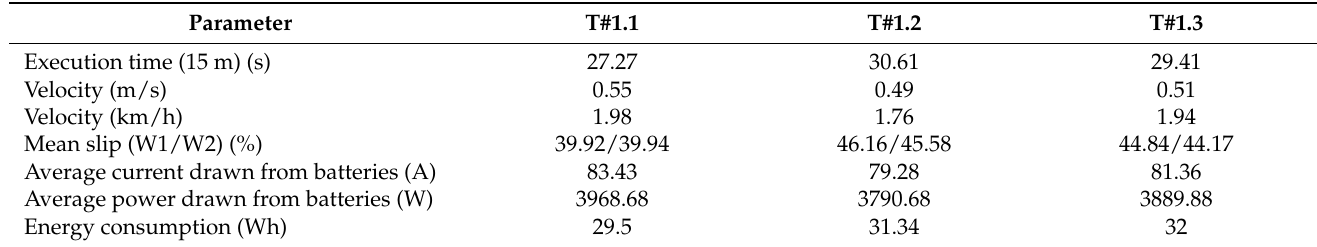
Figure 19. Energy consumption during the trial sessions carried out on firm soil and without slip control. Table 1. Summary of parameters measured during the trial sessions carried out on firm soil and without slip control.